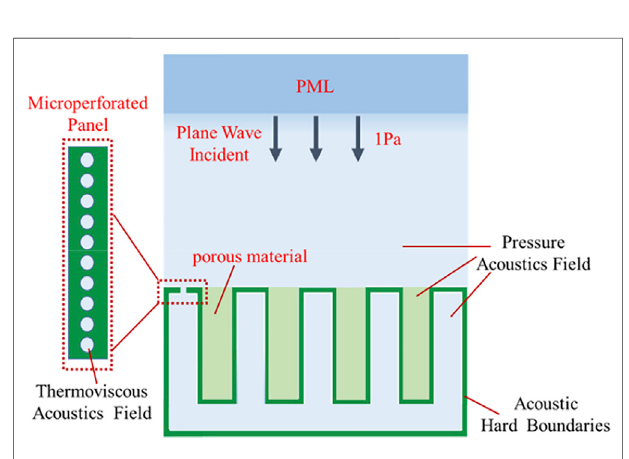
FIGURE 2 | Structure of acoustic liner and its